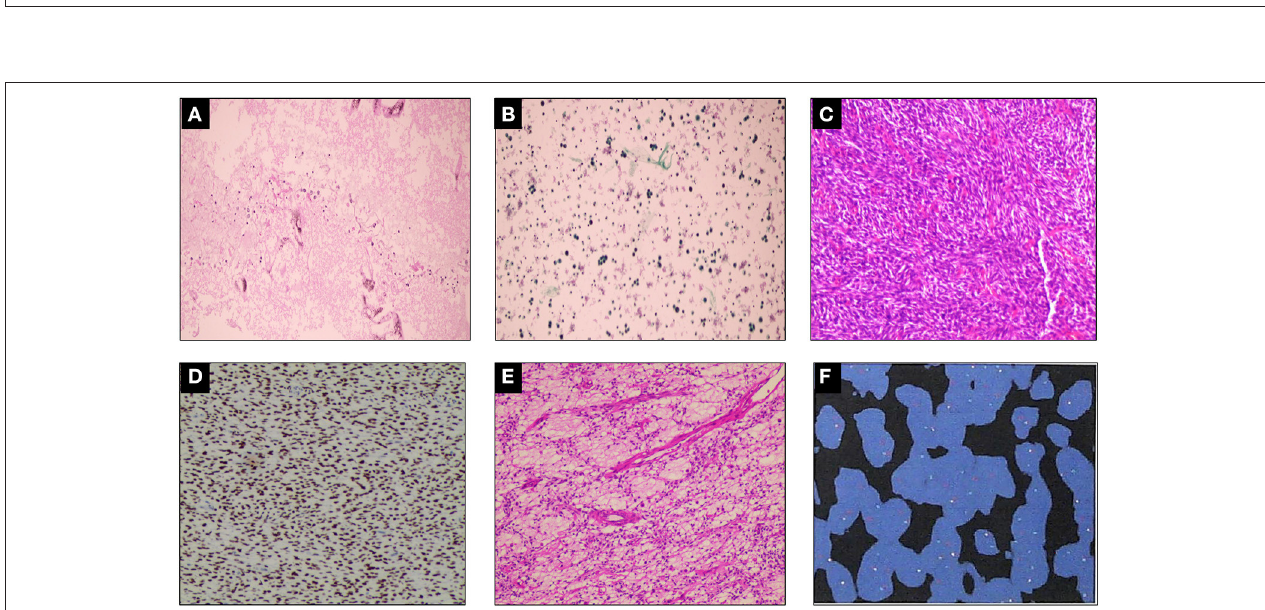
FIGURE 2 | Histopathological examination. (A) A small number of mesothelial cells and lymphocytes were found in the pleural effusion, but no malignant tumor cells were found. (B) Tissue cells, lymphocytes, and no malignant tumor cells could be found in the left pleural effusion. Mycobacterium tuberculosis was found to be negative by acid-fast staining (–). (C–E) Damaged tissue of pericardial tumor, which measured 20 × 17 × 5cm, with some gelatinous areas. Mesenchymal tissue-derived tumors, with dense spindle cell areas and edema areas, combined with immunohistochemistry, do not rule out SS. Immunohistochemistry results: CK (–), EMA (focal + ), TLEL ( + ), CD34 (–), S100 (–), CD99 (partial + ), Bcl-2 ( + ), Ki67 (hot spot 25% + ), WT-1 (–), Desmin (–), SMA (–), Vim ( + ), calponin (partial + ), INI-1 (–), ERG (–), p53 (30% weak + ), HMB45 (–), FLI-1 (–). (F) Fluorescence in situ hybridization (FISH) showing rearrangement of the SS18 gene, indicating positive result.